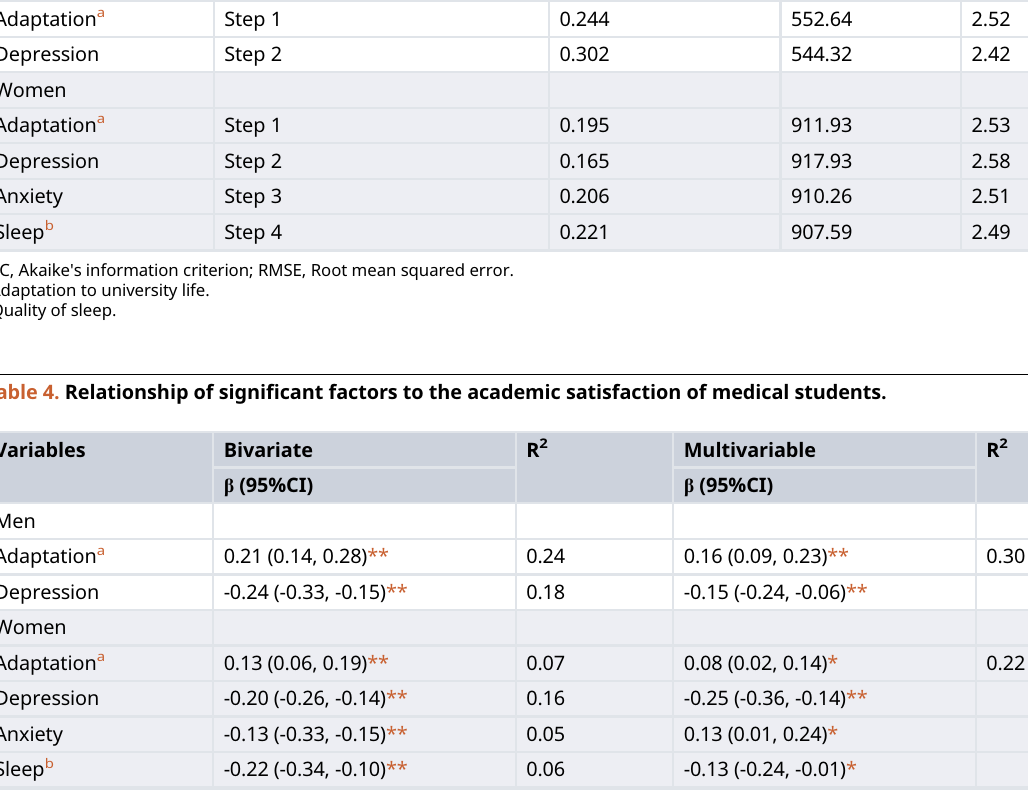
Multivariate models in males showed that a higher score in adaptation ( β : 0.16, 95% CI 0.09 to 0.23, p<0.01) and a lower score of depression ( β : -0.15, 95% CI -0.24 to -0.06, p<0.01) were related to increased student satisfaction and explain 30% of the changes in the adjusted model. On the other hand, in females a higher score of adaptation ( β : 0.08, 95% CI 0.02 to 0.14, p<0.01) and anxiety ( β : 0.13, 95% CI 0.01 to 0.24, p<0.01), while, a lower score in depression ( β : -0. 25, satisfaction. Overall, the model for women explained that 22% of changes in academic satisfaction (Table 4).